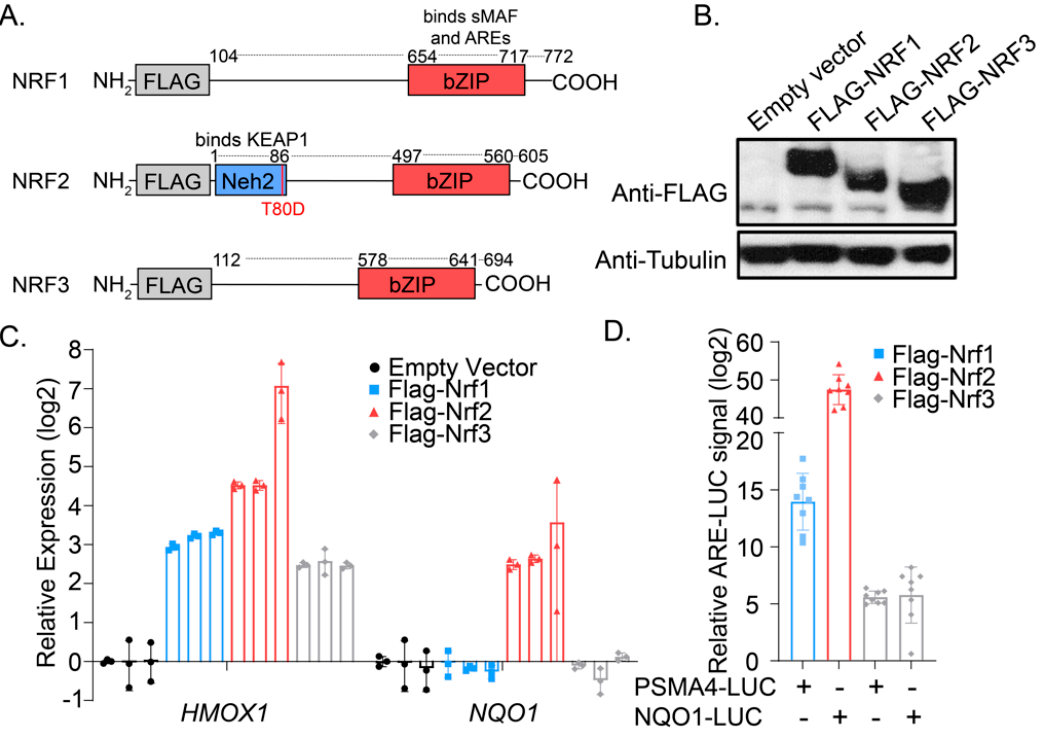
Figure 1. An overexpression system for evaluating the activities of NRF transcription factors in HEK293T cells. ( A ) Schematic depicting the FLAG-NRF constructs used in this work; numbers above each transgene indicate the amino acid positions of the reference ORF. ( B ) Western blotting analysis for FLAG protein content from HEK293T cells 24 h after transfection with the indicated constructs. ( C ) Transcript levels of HMOX1 and NQO1 as measured by qRT-PCR from HEK293T cells 24 h after transfection with the indicated constructs ( n = 3; mean and s.d.). ( D ) Relative ARE reporter activity from HEK293T cells overexpressing the indicated FLAG-NRF construct ( n = 8; mean and s.d.).